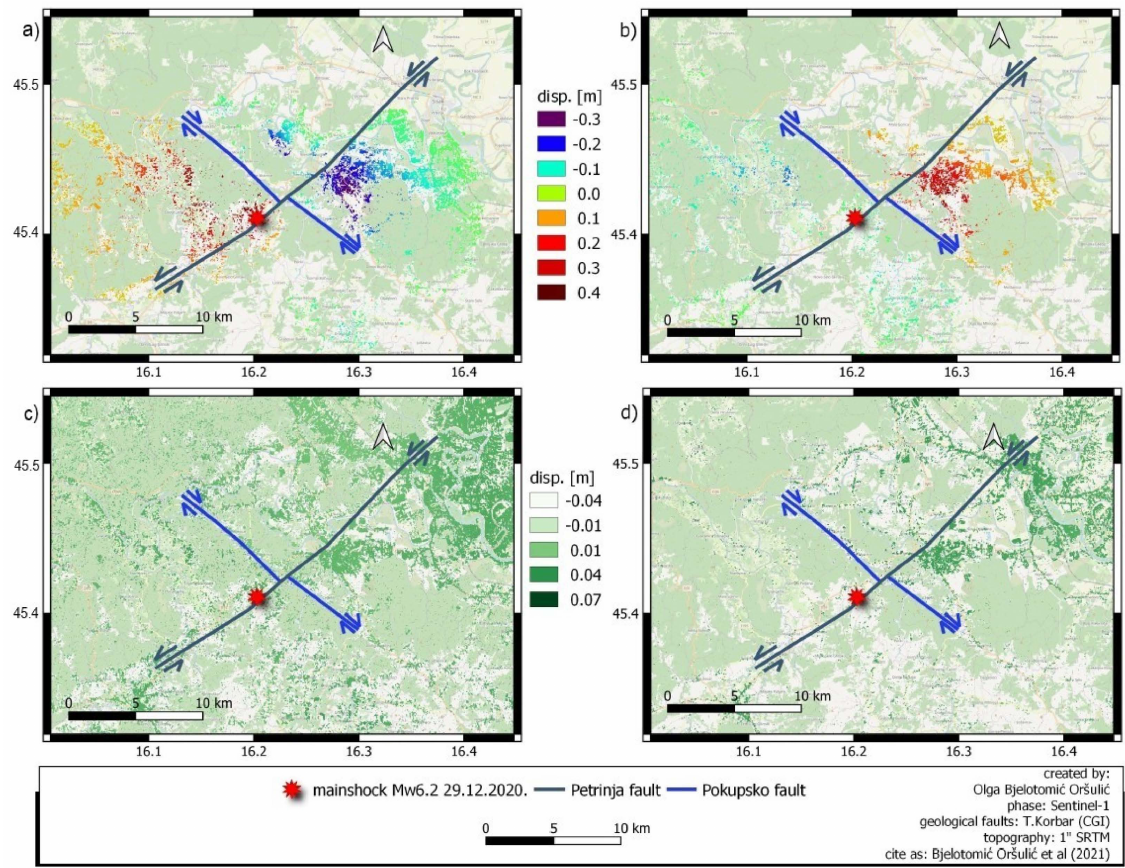
Figure 7. Figure shows LOS displacement in the period between ( a ) 18 December 2020 and 30 December 2020 from a